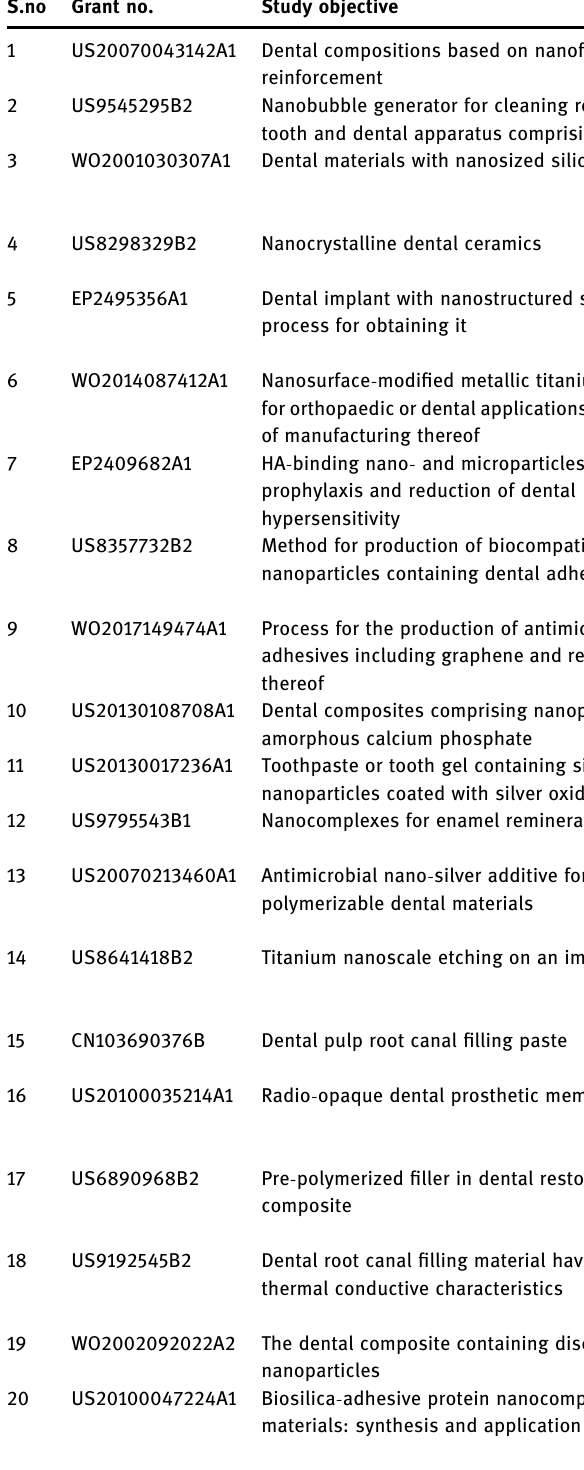
Table 2: Patents on nanotherapeutic tools for dental intervention S.no Grant